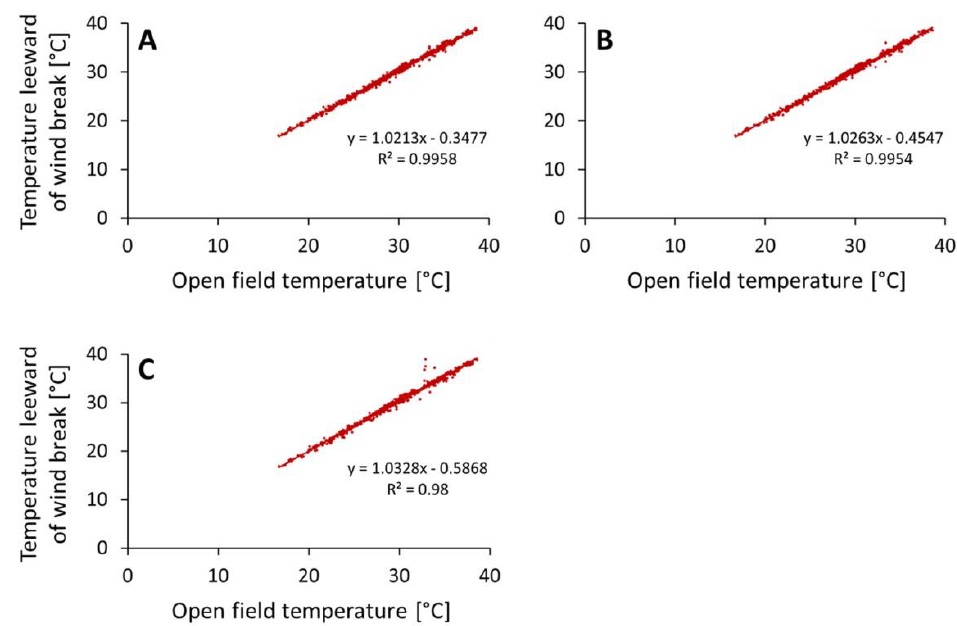
Figure 3. Air temperature of open field conditions (T open field ) versus temperature (T wind break ) leeward of the single row tree wind break at the following distances from the tree wind break: 13.7 * H (in subgraph A ), 21.25 * H (in subgraph B ), and 26.8 * H (in subgraph C ). Distances are expressed in multiples of wind break tree height (H).